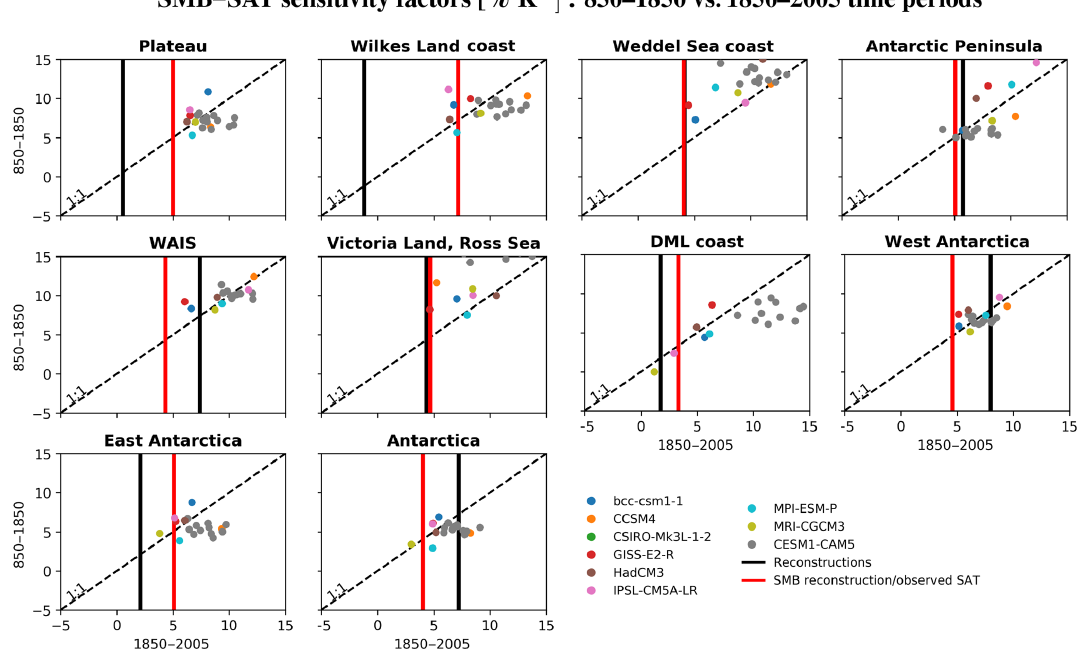
Figure 5. SMB sensitivity to surface air temperature (SAT) over the 850–1850 and the 1850–2005 periods for each Antarctic region (see Fig. 1 for geographical definitions) for GCM outputs. Additionally, the SMB– δ 18 O sensitivity for ice-core-based reconstructions (i.e., Thomas et al., 2017; Stenni et al., 2017a) over 1850–2005 is represented by a solid black vertical line while a solid red vertical line represents the SMB-observed surface air temperature sensitivity (i.e., Thomas et al., 2017; Nicolas and Bromwich, 2014a) over 1960–2010. For the CESM1–CAM5 model, the 12 simulations are plotted as grey